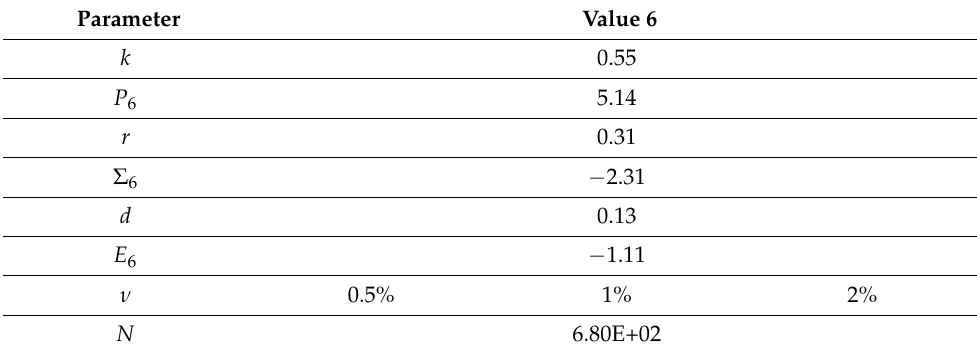
Table 6. Parameter values of the global warming